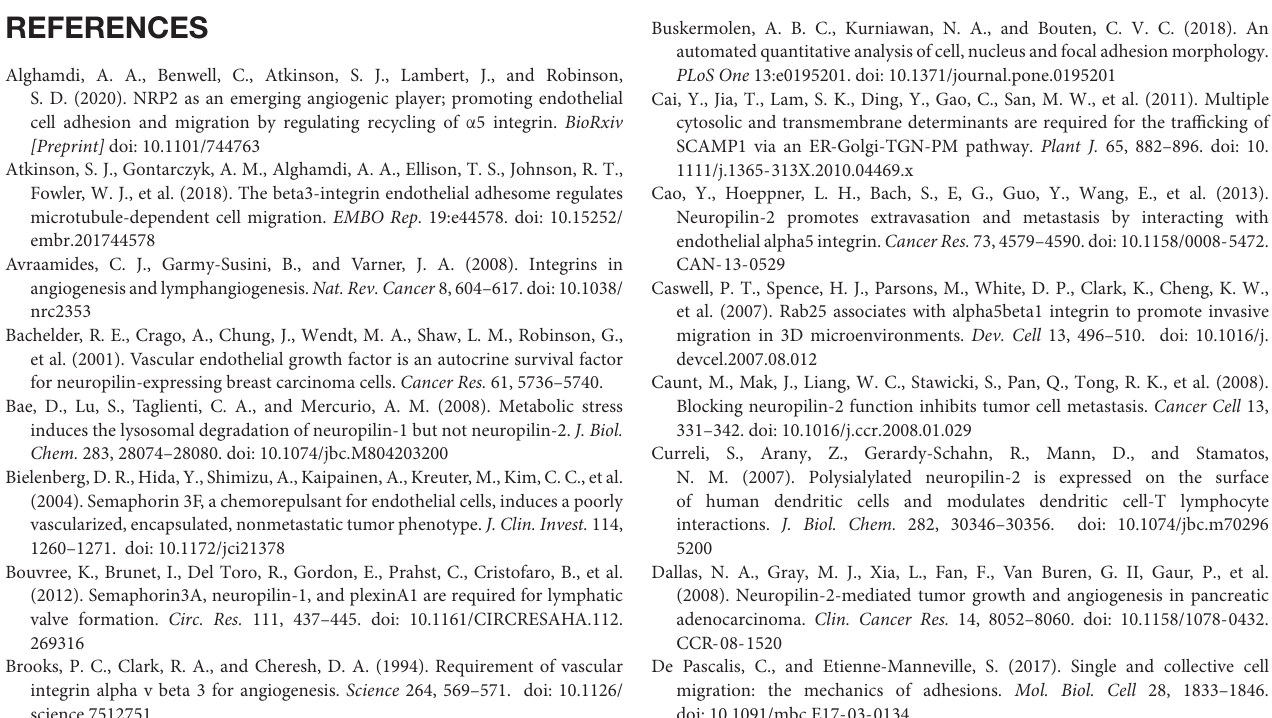
incubation in secondary antibody. Coverslips were subsequently mounted and the number of cells in S-phase (proliferating cells) was determined by dividing the number of the BrdU-labeled cells by the number of DAPI-labeled cells. n = 19 independent fields of view, containing on average 50 cells per field, per condition. (B) : Adhesion assay performed as described in Figure 2A , however, ECs were transfected with either control or NRP2 siRNA#04. Bars show mean number of adhered cells calculated from absorbance readings from 40 wells per condition, per timepoint, normalized to a 3-h incubation control plate, N = 1. (C) : Accompanying analysis to Figure 2D . The cell area (microns 2 ) was measured using ImageJ TM . Quantification performed on mean data from n ≥ 25 ECs over N = 3 independent experiments, nsd = not significantly different from unpaired two-tailed t -test. (D) : siRNA-transfected ECs were prepared as described in Figure 2D legend, measuring mean FA number, FA size and FA distribution, however, ECs were transfected with either control or NRP2 siRNA#04. Quantification performed on mean data from n = 15 ECs. Asterisks indicate statistical significance from an unpaired two-tailed t -test. FIGURE S3 | (A) : Accompanying analysis to Figure 3D . siRNA-transfected ECs were prepared for immunocytochemistry as described in Figure 2C . Fixed ECs were incubated in primary antibodies against ITGA5 overnight at 4 ◦ C. ITGA5 length was measured using the ImageJ TM software plugin simple neurite tracer. n = 490 cells per condition, ∗∗∗∗ P (0.0001). Asterisks indicate statistical significance from unpaired two-tailed t -tests. (B) : siRNA-transfected ECs from three different immortalized EC lines were prepared as described in Figure 3D legend, however, ECs were transfected with either control (top) or NRP2 siRNA#04 (bottom). Panels show representative images from N = 3 independent lines, n ≥ 10 cells per line. (C) : Western blot analysis of cell lysates from both primary EC clones alongside a lysate from a known fibroblast control cell line. EC extracts were immunoblotted using antibodies against known EC markers Endomucin, ERG and Claudin-5, alongside a GAPDH loading control. (D) : Primary ECs were transfected with either ctrl or NRP2 siRNA and prepared for immunostaining as described in Figure 3E . Panels show representative images from n = 10 cells per condition from two independent primary EC lines. TABLE S1 | NRP2-immunoprecipitating label-free quantitative (LFQ) mass spectrometry